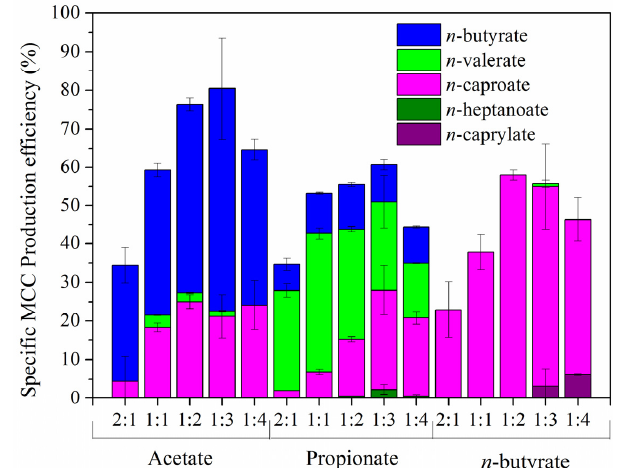
Figure 7. Specific medium chain carboxylate (MCC) production efficiency at different acid/ethanol ratios with acetate, propionate, and n-butyrate as the electron acceptor, respectively (Total MCC